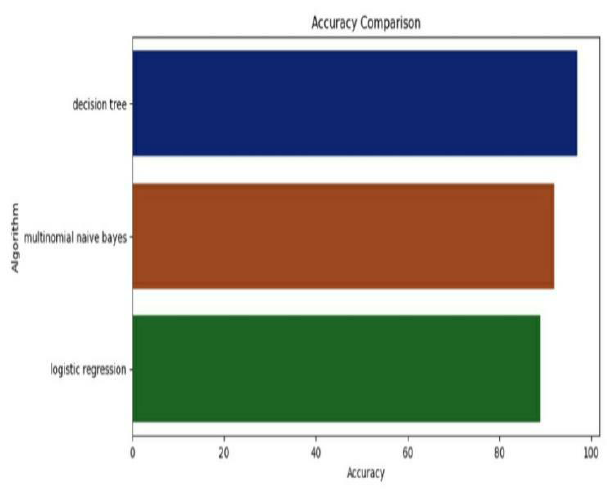
Fig. 4. Accuracy comparison of the algorithms The accuracy comparison shown in the Fig. 4. portray the comparison between the three algorithms -